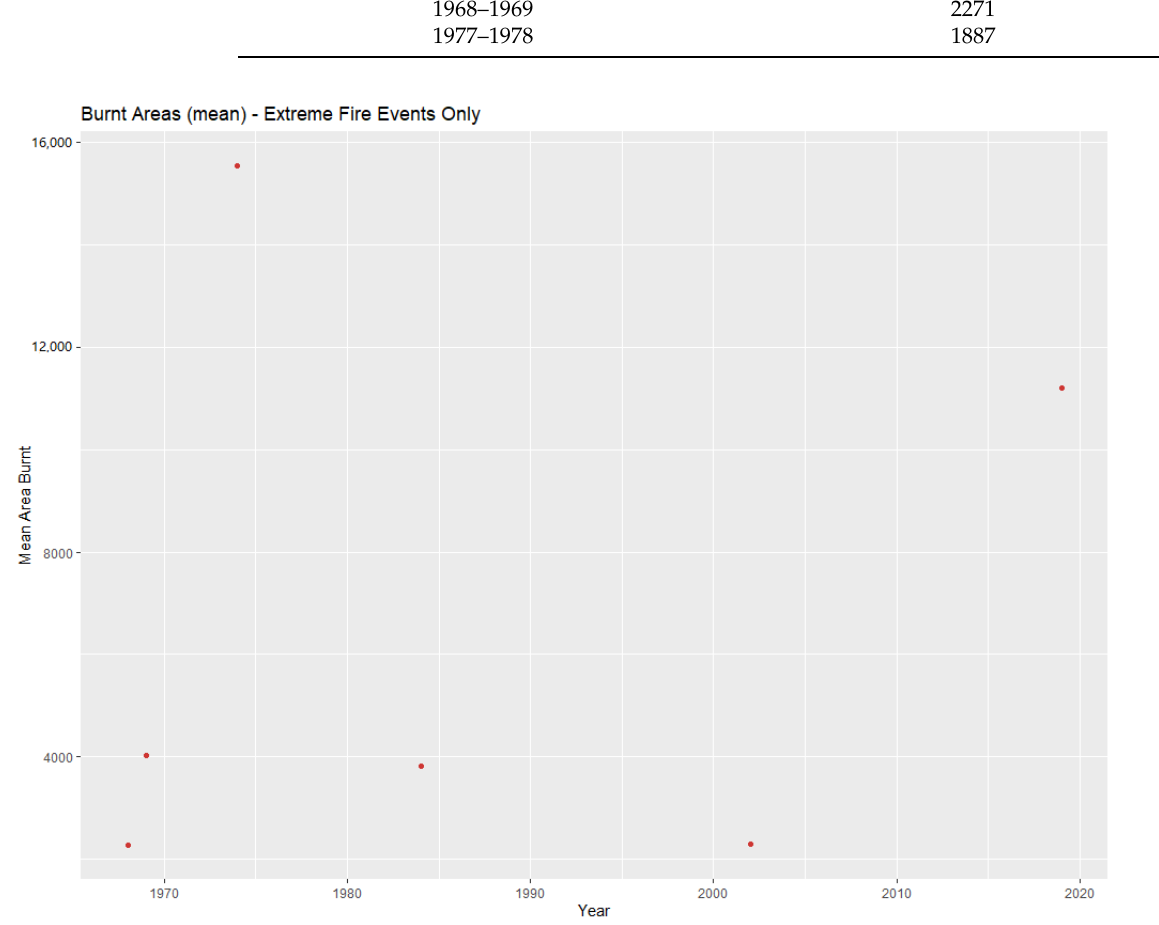
Figure 9. Extreme fire events.